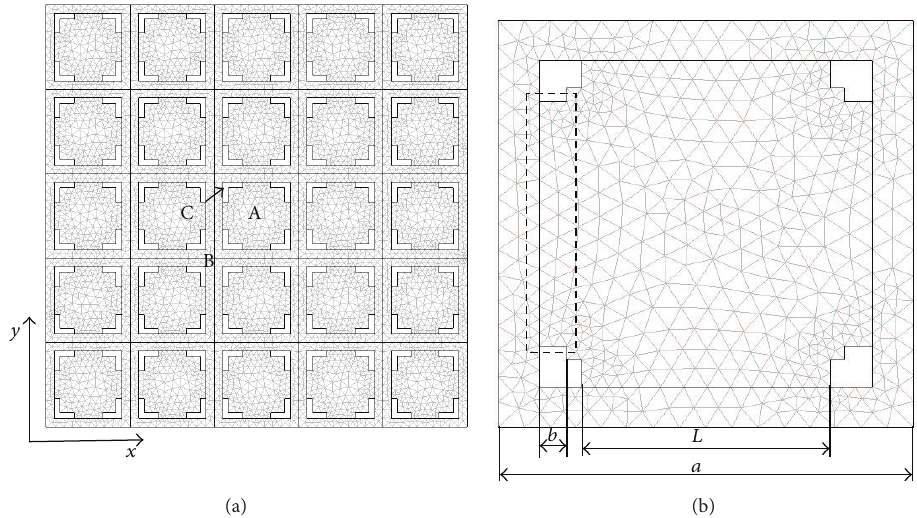
Figure 1: The cross-section structure of the phononic crystal (a) and the unit cell structure of the phononic crystal